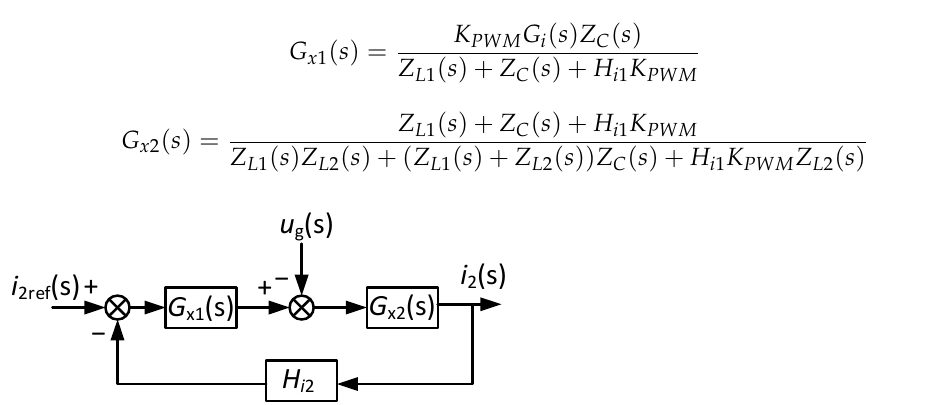
Figure 6. Block diagram of the FOGCI control system with capacitor current proportional feedback (C apacitor current proportional feedback can be eliminated if α + β ≠ 2).